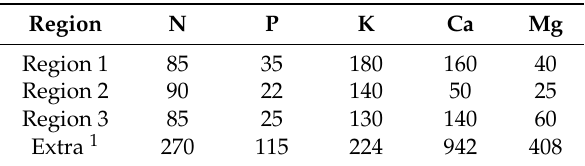
Table 2. Total amount of macronutrients (kg ¨ ha ´ 1 ) applied to the conventional fertilization plots and the extra fertilization twin plots.